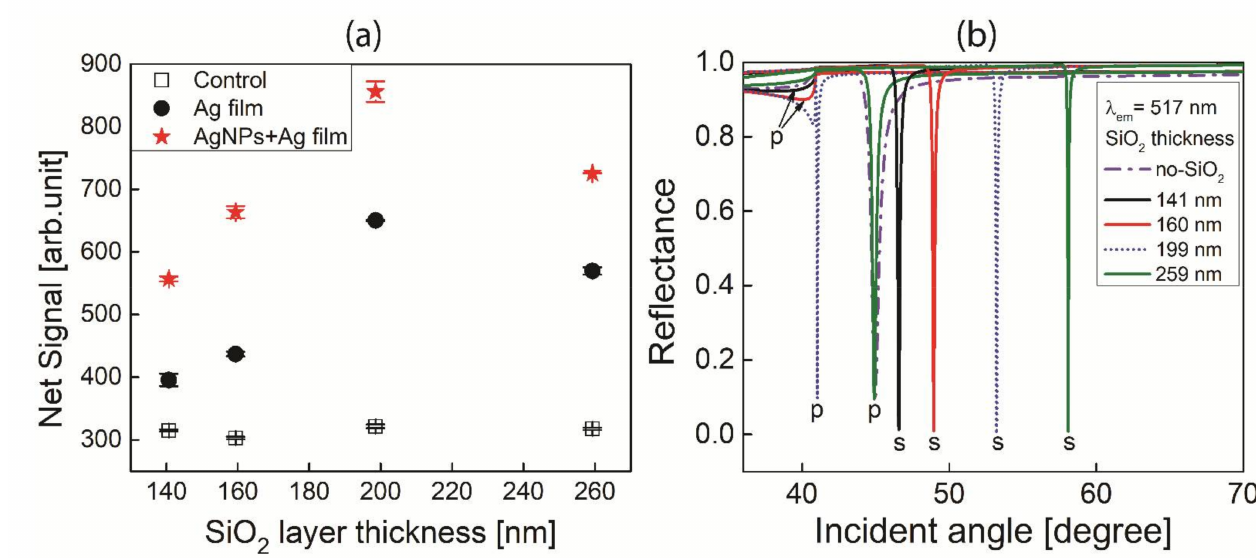
Figure 5. ( a ) Net signals obtained from measurement setup of Figure 3a at wavelengths of 525 ± 25 nm using the four different chips seen in Figure 1(b3,b4). The thicknesses of the SiO 2 layer wherein rhodamine 110 molecules were dispersed were 141, 159, 199, and 259 nm. Error bar = ± SD, n = 3. ( b ) Numerical simulation of reflectance versus incident angle in a Kretschmann configuration at λ em for p- and s-polarizations that was assumed to have a SiO 2 layer/50 nm Ag film on its prism base. Optical parameters used for calculation are found in Section S3 in Supplementary